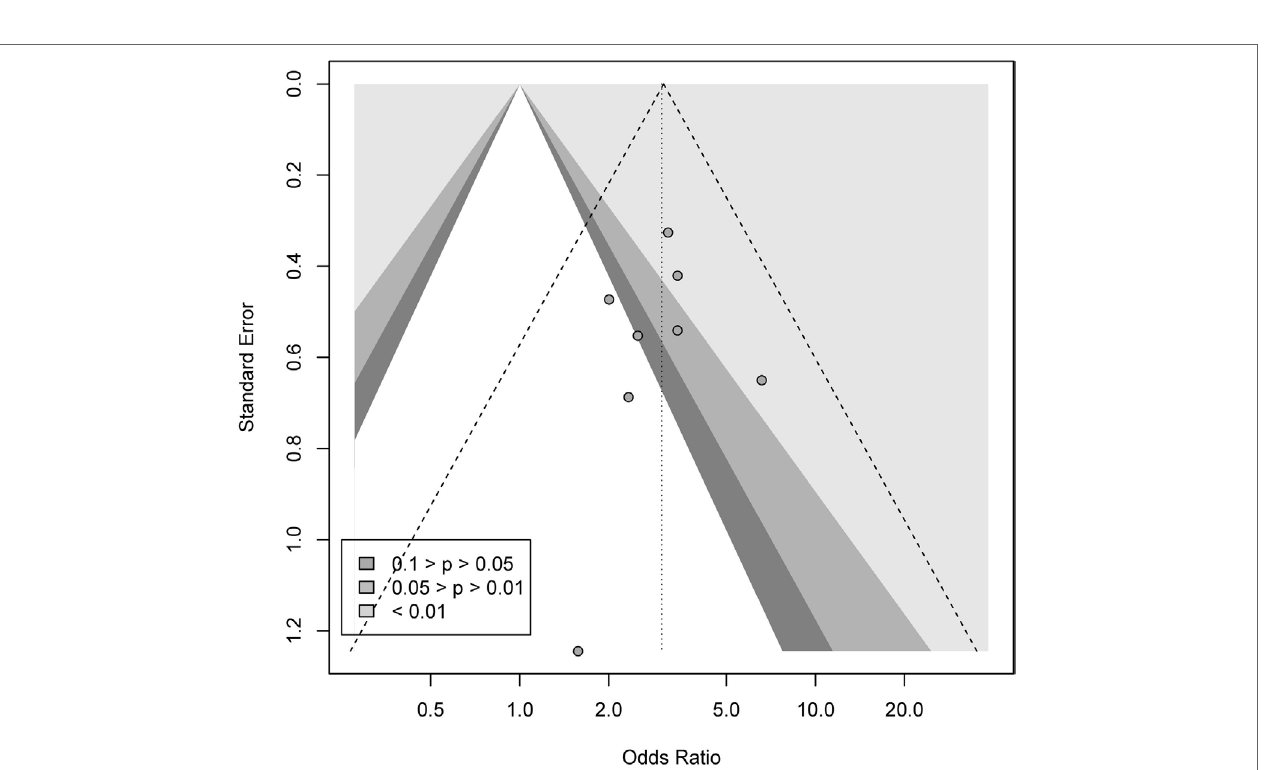
FigURe 12 | Contour-enhanced funnel plot for punding.